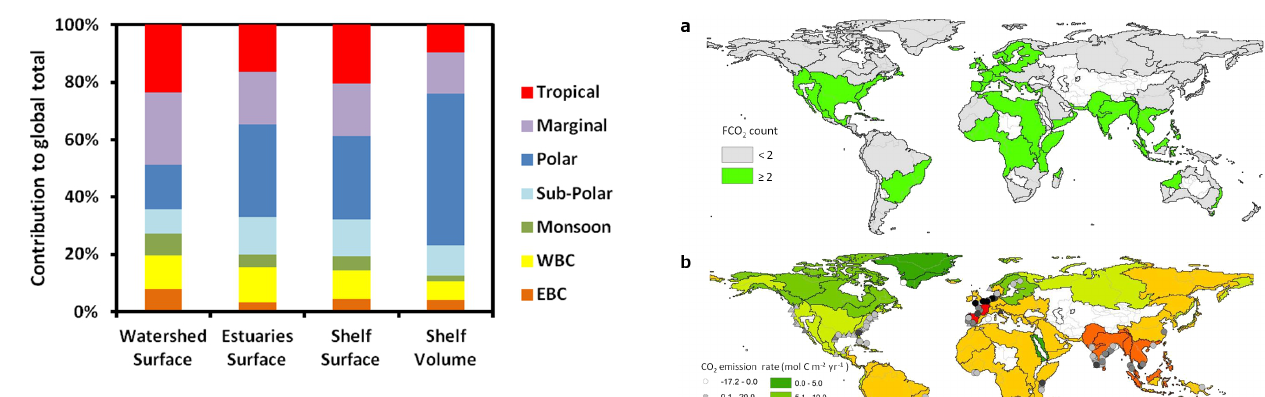
Fig. 6. Contribution of each MARCATS class to the global water- shed surface area, estuarine surface area, continental shelf surface area and continental shelf volume.